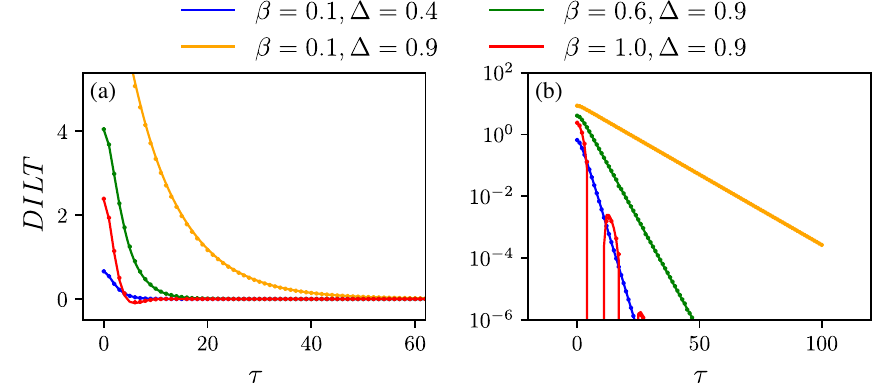
FIG. 9. Numerical double inverse Laplace transform (DILT) of Eq. (C1) (circles) and its analytical counterpart [Eq. (C2)] (solid lines), as functions of time. (a) Linear and (b) log-linear scales. The legend applies to both